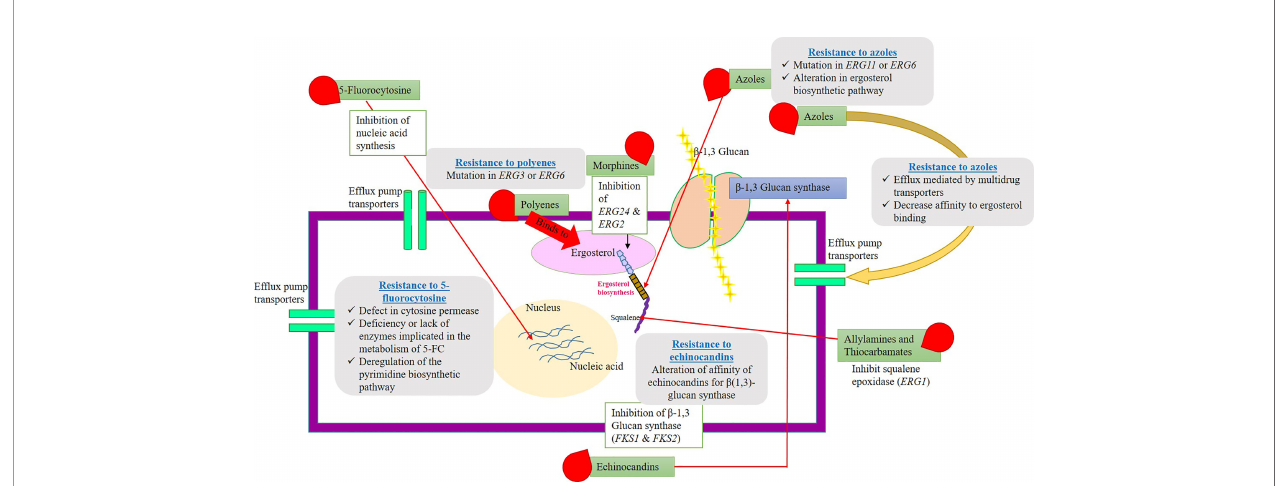
FIGURE 2 | Schematic representation of fungal cell wall, antimycortic drugs, possible antifungal activity (target site), and resistance to commercial antifungal drugs. The picture explains various antifungal compounds and their target site on the pathogenic fungi. Along with that, the plausible resistance mechanisms evolved by the fungal species to clinically approved antimycotic drugs have clearly depicted. Resistance gene/proteins/channels might be antifungal targets for the development of novel antimycotic compounds or alternative chemosensitization/drug repurposing